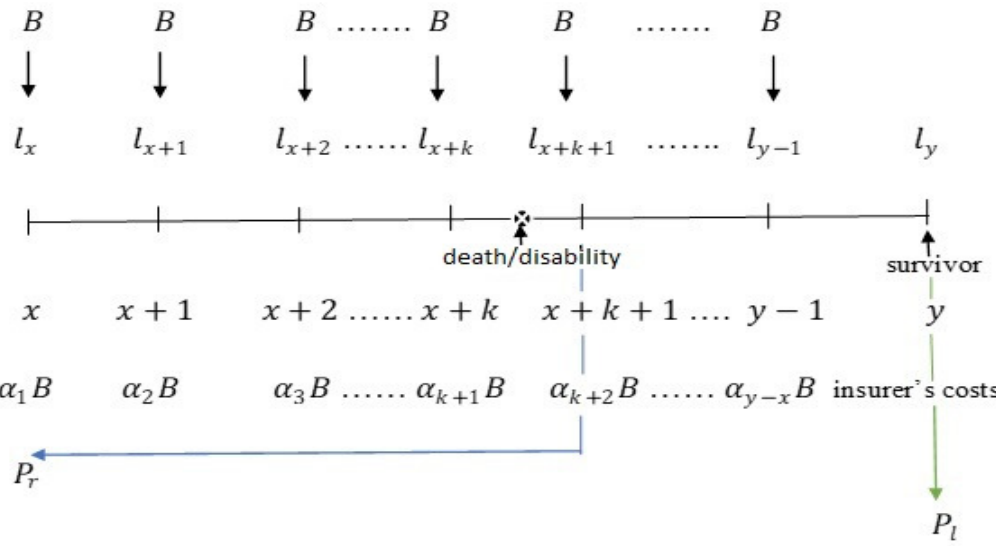
Figure 4. Schematic drawing of the accumulative pension scheme with possibility of inheritance based on two decrement factors and with annual contributions and a lump sum payment on